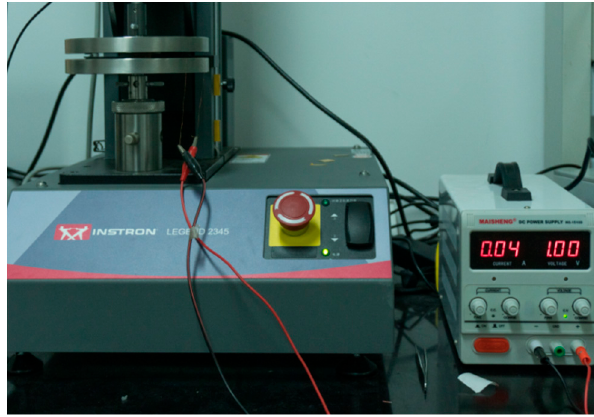
Figure 2. Contact resistance testing device.